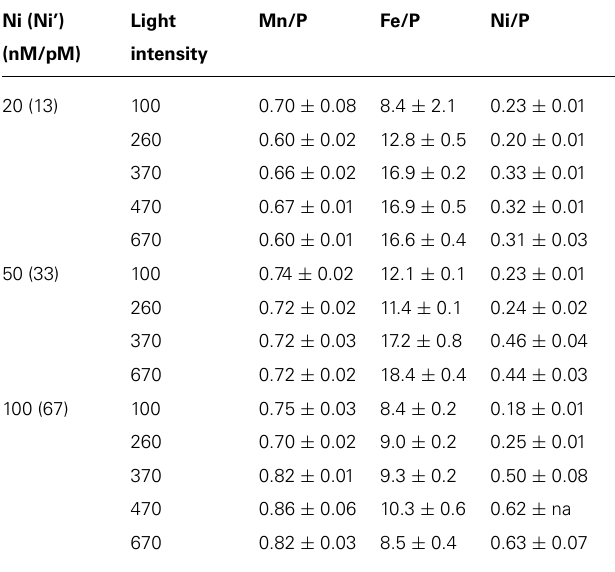
Table 1 |Trace metal quotas to P (mmol/mol) in Trichodesmium grown under various Ni availability and light intensity ( μ E m –2 s –1 ). The total dissolved and the estimated inorganic Ni (Ni’) concentrations in the culture media are shown in the first